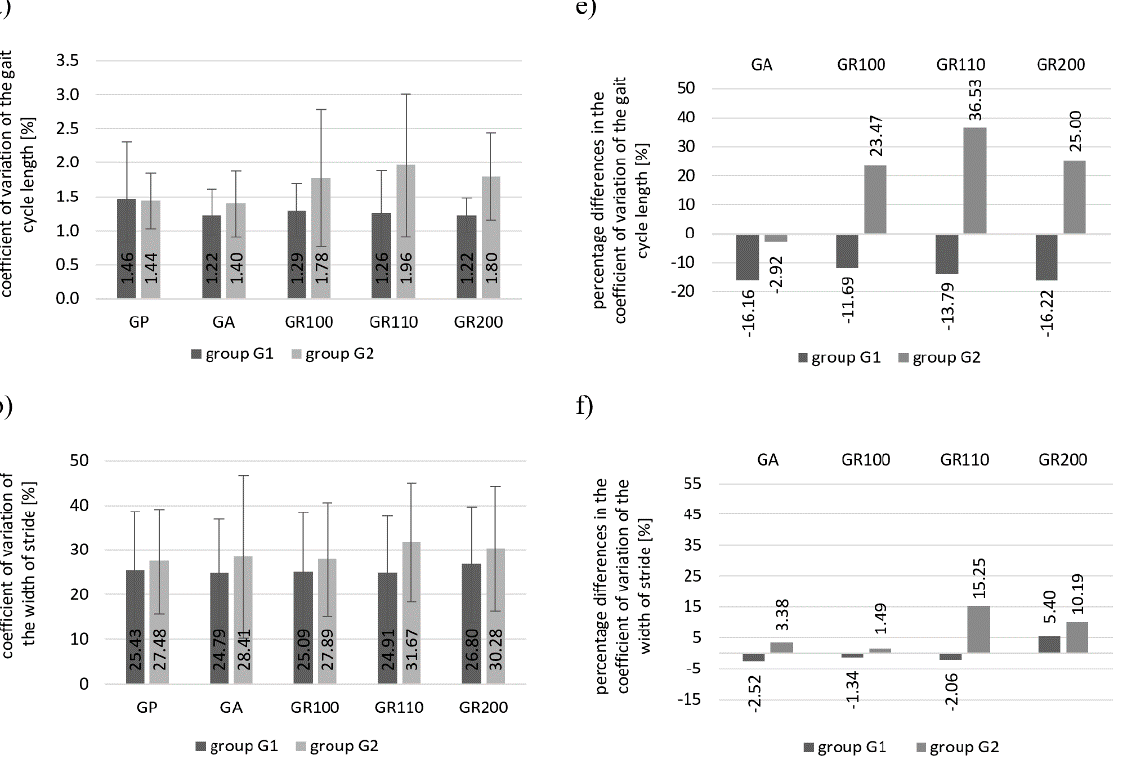
Figure 2. Coefficient of variation and percentage differences in the coefficient of variation for groups G1 and G2 obtained in particular tests for the analyzed parameters of gait: ( a , e ) length of the gait cycle; ( b , f ) stride width; ( c , g ) time of the gait cycle; ( d , h ) frequency of taking steps. (CV—coefficient of variation, G1—group 1, G2—group 2, RAS—rhythmic auditory stimulation, GP—reference gait test without auditory stimuli, GA—gait test with arrhythmic stimulus, GR100—gait test with rhyth- mic stimulus played at a rate corresponding to the frequency of gait, GR110—gait test with rhythmic stimulus played at a rate corresponding to gait frequency increased by 10%, GR200—gait test with rhythmic stimulus played at a rate corresponding to doubled gait frequency).